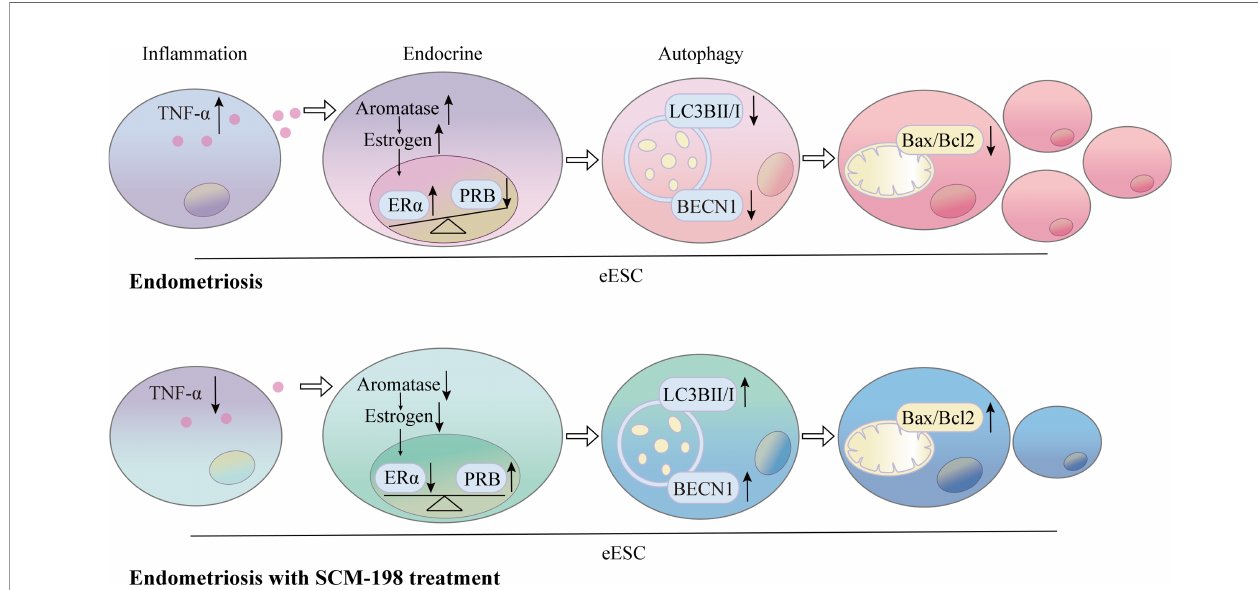
FIGURE 7 | Schematic showing the therapeutic mechanism of SCM-198 on EMS. The production of TNF- a was higher in eESCs than that in nESCs. Elevated TNF- a levels augmented the activation of aromatase-estrogen-ER a signaling and aggravated PRB reduction. The upregulated estrogen signaling and downregulated progesterone signaling synergistically suppressed the autophagy level, which further led to the growth of eESCs. SCM-198 inhibited aromatase-estrogen-ER a signaling and increased PRB expression by downregulating TNF- a . Consequently, SCM-198 promoted the autophagy-mediated apoptosis of eESCs by reconstructing the balance of estrogen and progesterone